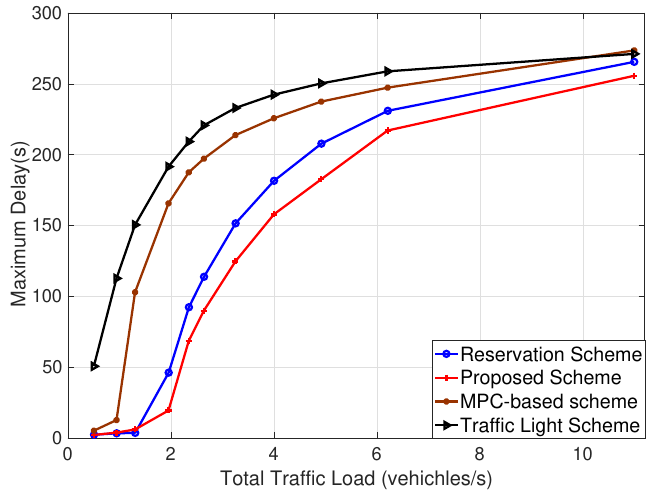
Figure 7. Maximum delay comparison under different